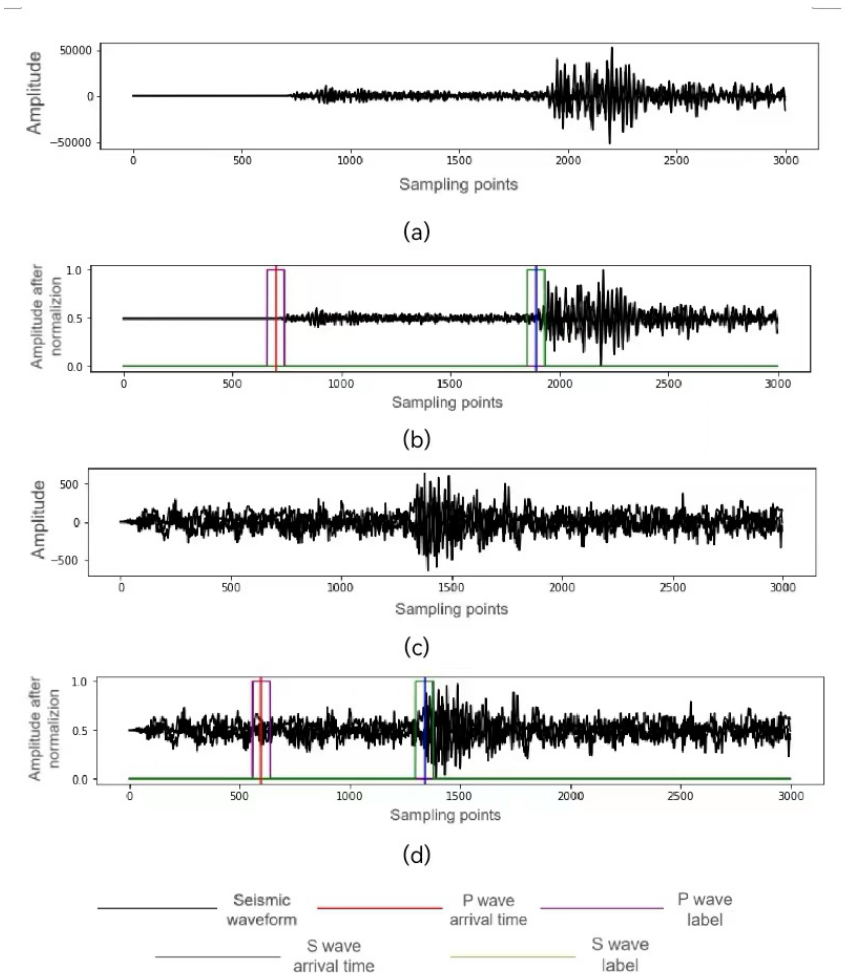
Figure 5. Data distribution before and after data processing (( a , c ) are the original data, ( b , d ) are the label data after manual labeling.The red vertical line represents the arrival of the P-wave, the blue vertical line represents the arrival of the S wave, the purple box represents the label range of the P-wave, and the green box represents the label range of the S wave)